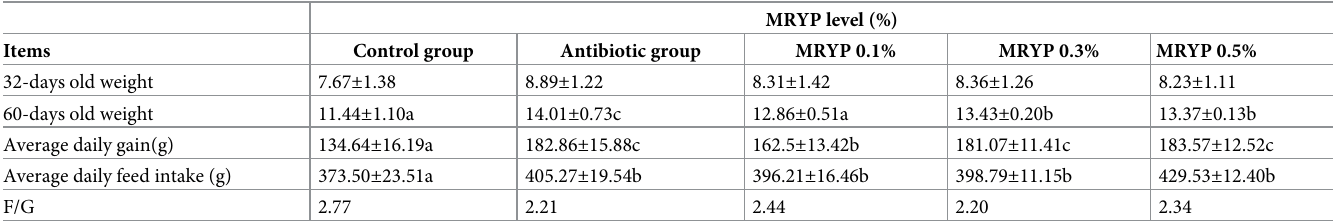
Table 9. Effect of MRYP on body